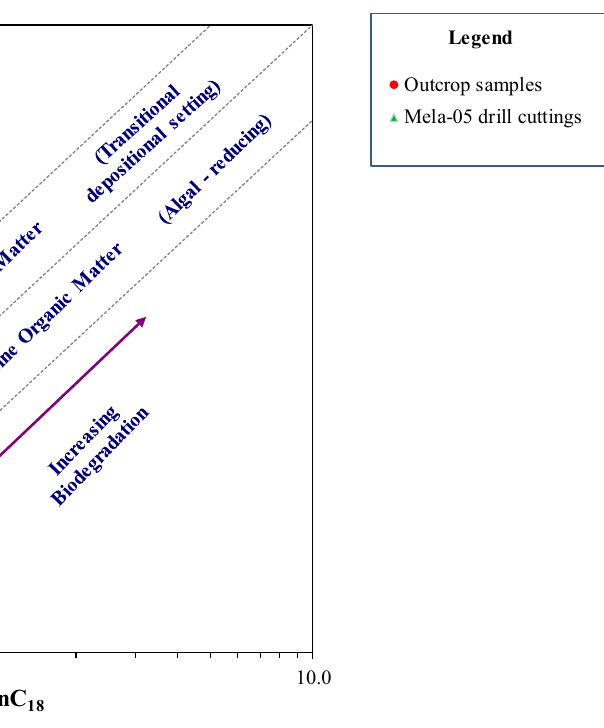
Fig. 8 The cross-plot of Ph/nC 18 versus Pr/nC 17 indicates the environment of deposition, source input and thermal maturation level of the sam- ples (after Shanmugam